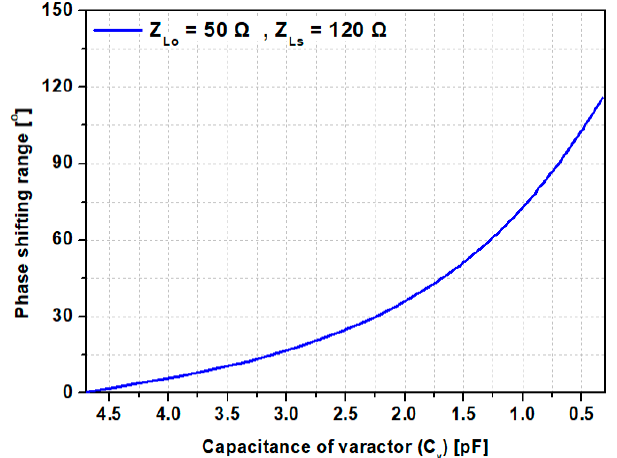
Figure 6. PSR with C v variations at f H ( C v = 4.7 to 0.3 pF @ f H ).